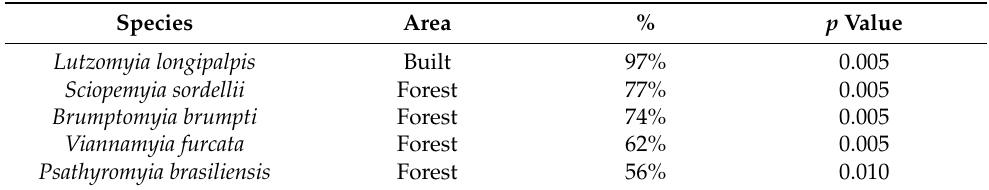
Table 3. Bioindicator species analysis of sand flies in the forest areas and in the built areas of Jo ã o Pessoa, Para í ba, Brazil.